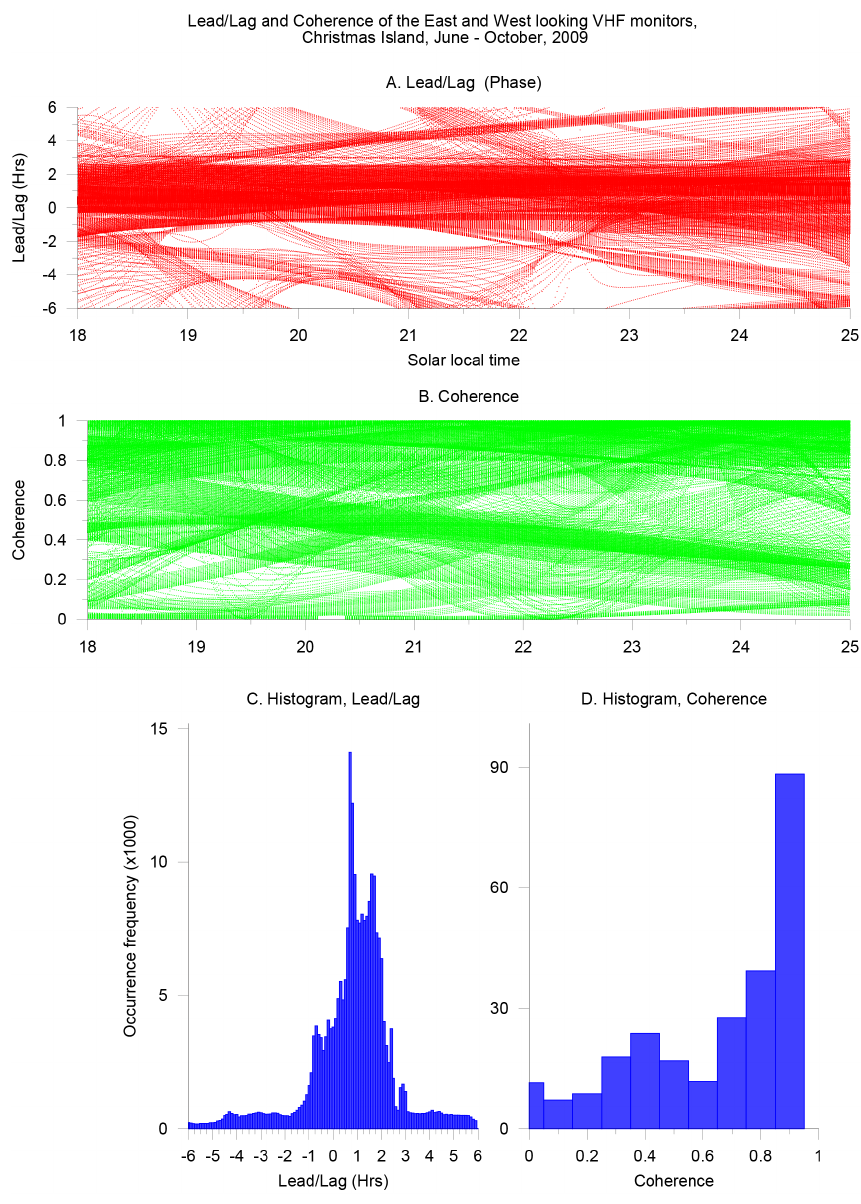
Fig. 4. Same as Fig. 3 but for peak scintillation season in